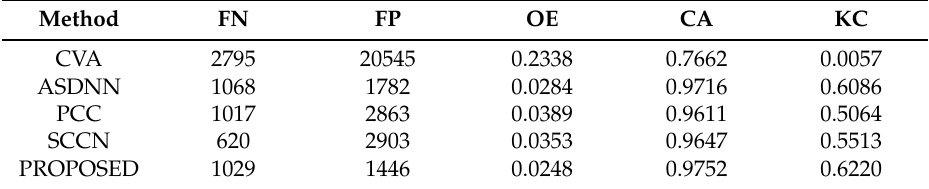
Table 3. Values of the evaluation criteria on the Yellow River dataset by different methods.